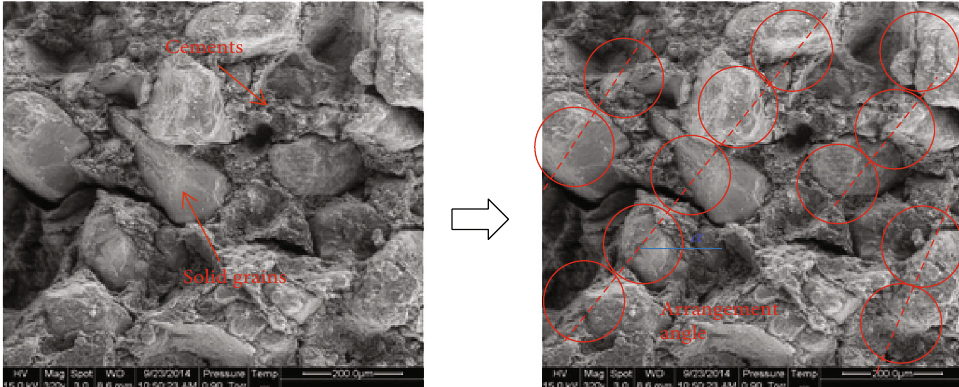
Figure 18: Microstructures by the ESEM and methods of obtaining the arrangement angle.